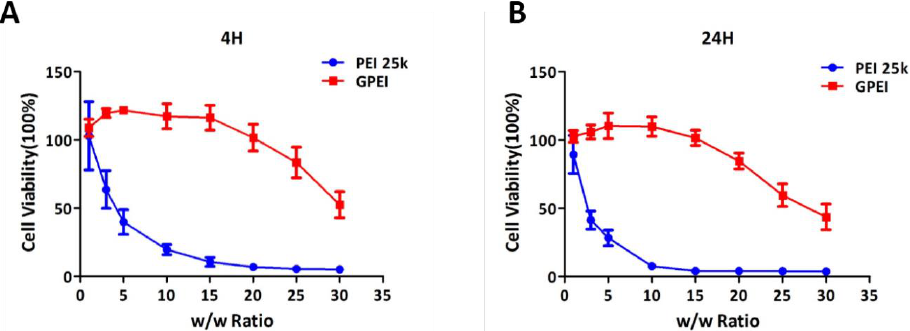
Figure 4. Cell viability of human umbilical vein endothelial cells (HUVECs) treated with the GPEI and PEI 25 kDa polyplexes. ( A ) Cell viability of HUVECs for 4 h. ( B ) Cell viability of HUVECs for 24 h. Data are shown as mean ± S.D. ( n = 6).